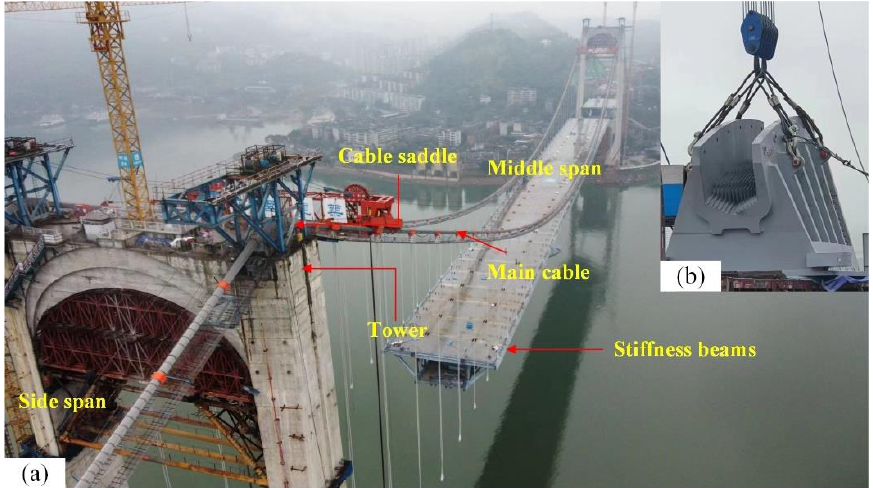
Figure 2. Main components of the Guojiatuo Suspension Bridge upper structure. ( a ) Cable saddle and tower. ( b ) Enlarged detail of the cable saddle.